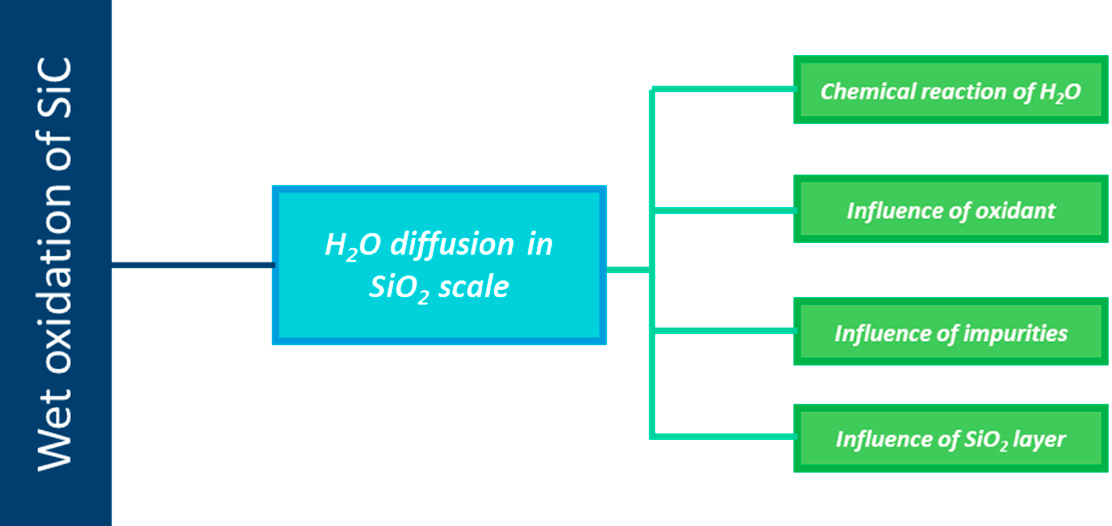
Figure 14. Layout of the wet oxidation part of the review.